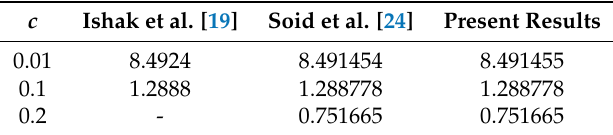
Table 1. Comparison results of f (cid:48)(cid:48) ( c ) with those of Ishak et al. [19] and Soid et al. [24] when λ = 0 and Pr = 1.